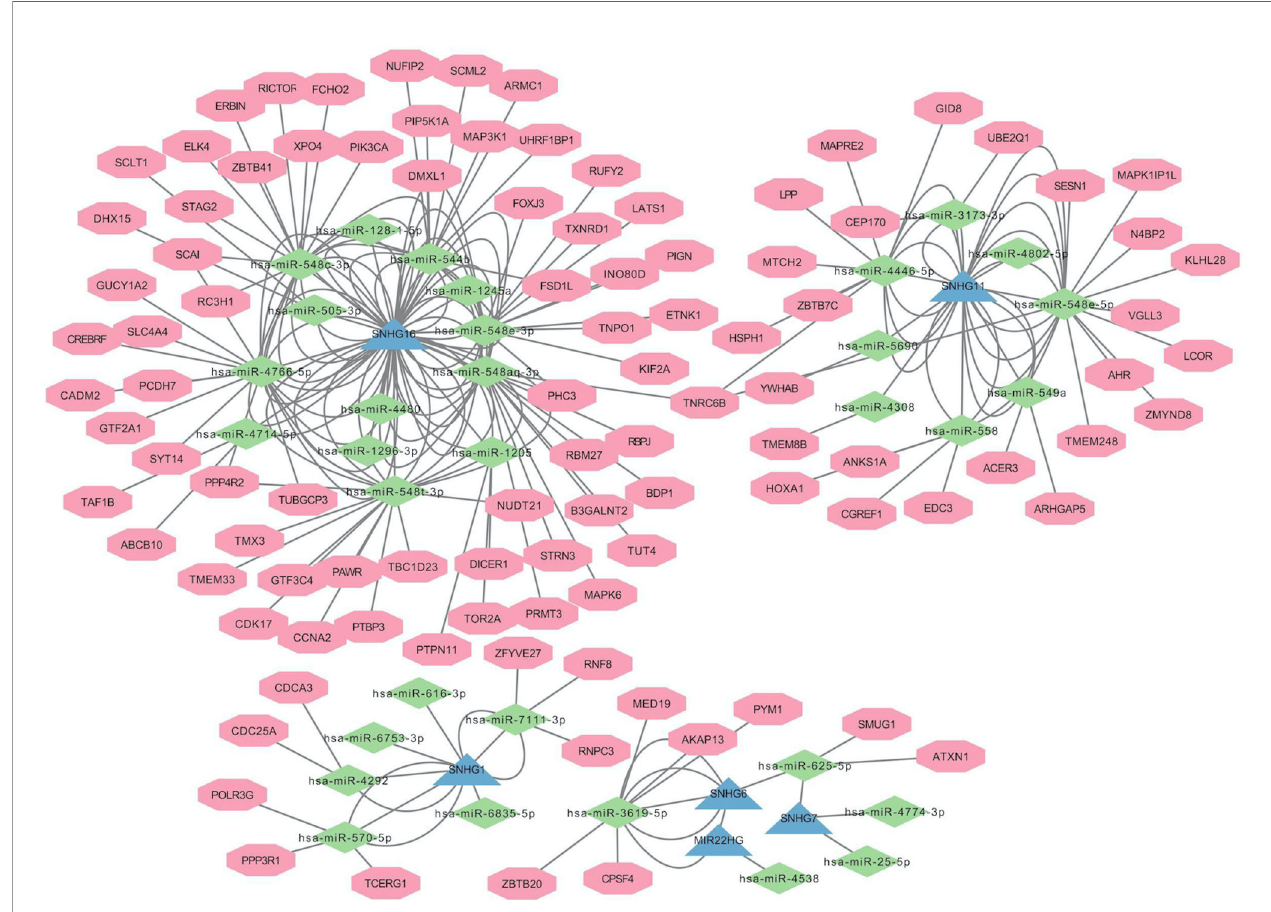
FIGURE 3 | Construction of ceRNA Network of Candidate